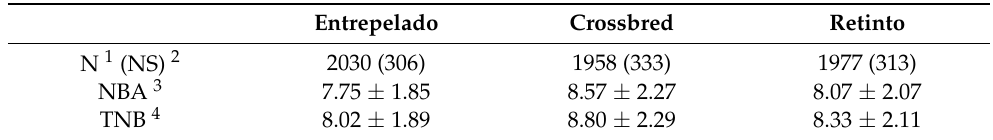
Table 1. Number of records (and number of sows between brackets) and the mean ± standard deviation of the number born alive and the total number born in Entrepelado, Crossbred and Retinto